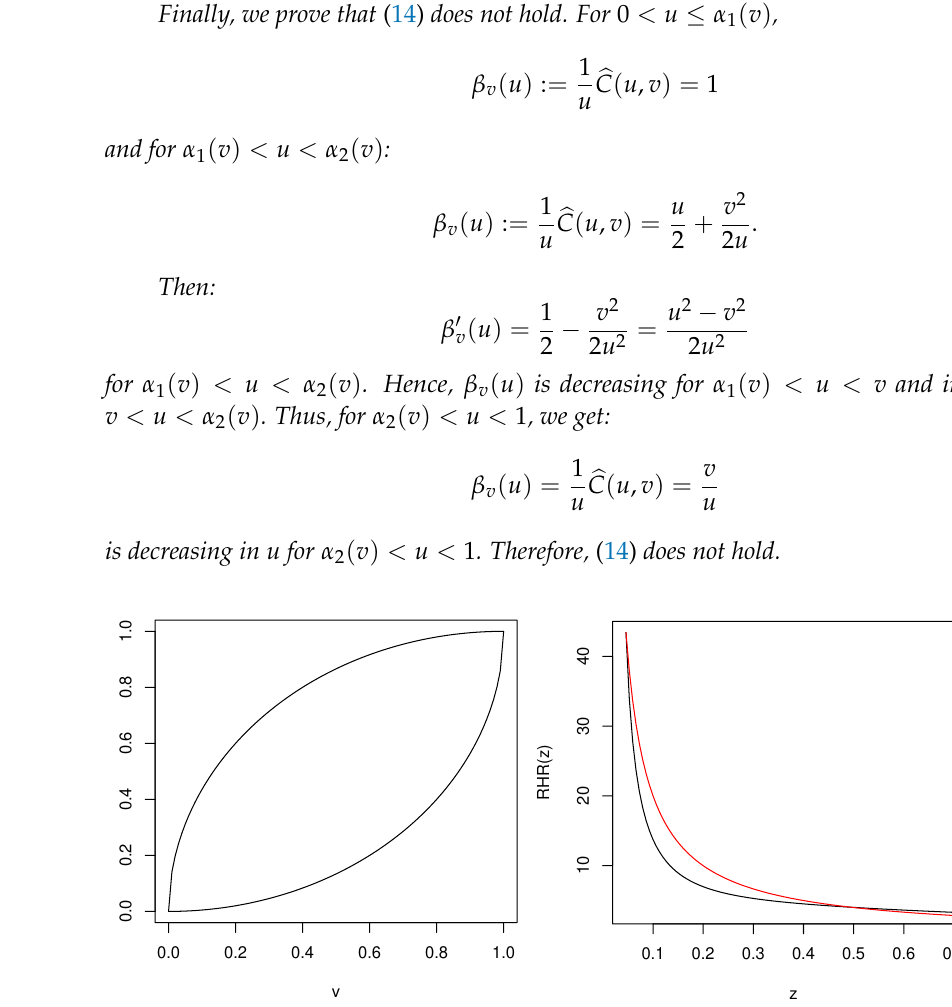
Figure 1. Functions ( left ) α 1 (down) and α 2 (top) for the copula in Example 2. Reversed hazard rate functions ( right ) for Z v (black) and Z 1 (red) when v = 0.3 for the copula in Example